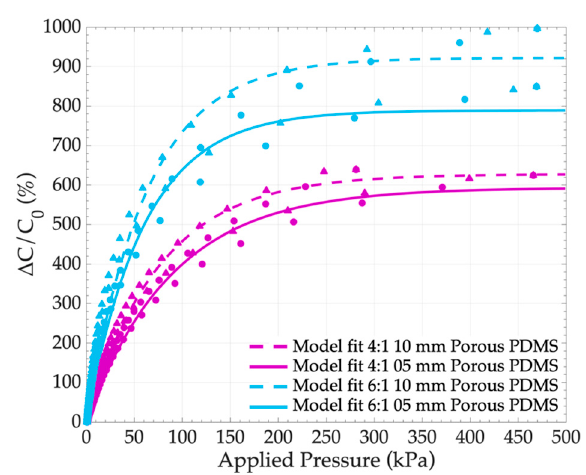
Figure 9. Variation of the capacitance according to the applied pressure depending on the thickness of the porous PDMS medium pores with sugar:PDMS ratios of 4:1 and 6:1. Table 3. Summary of characterization results for PDMS foams as a function of the sugar:PDMS ratio and pore size, for two di ff erent thicknesses ( d 0 = 5 mm ± 0.5 mm and d 0 = 10 mm ± 0.5 mm).